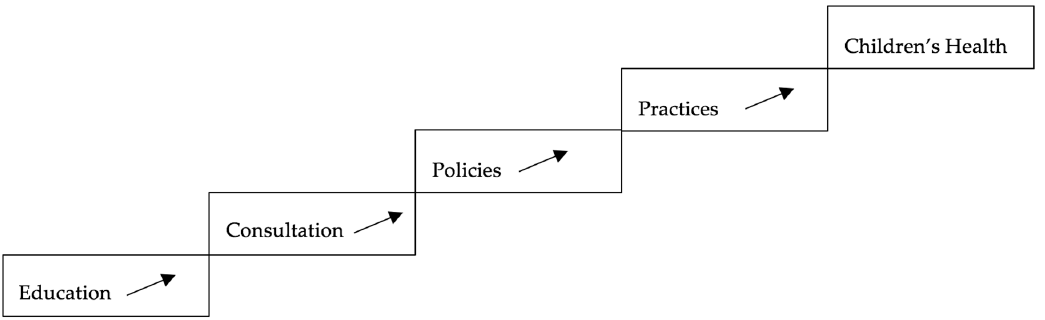
Figure 2. The Child Care Health Consultation Stepwise Model.